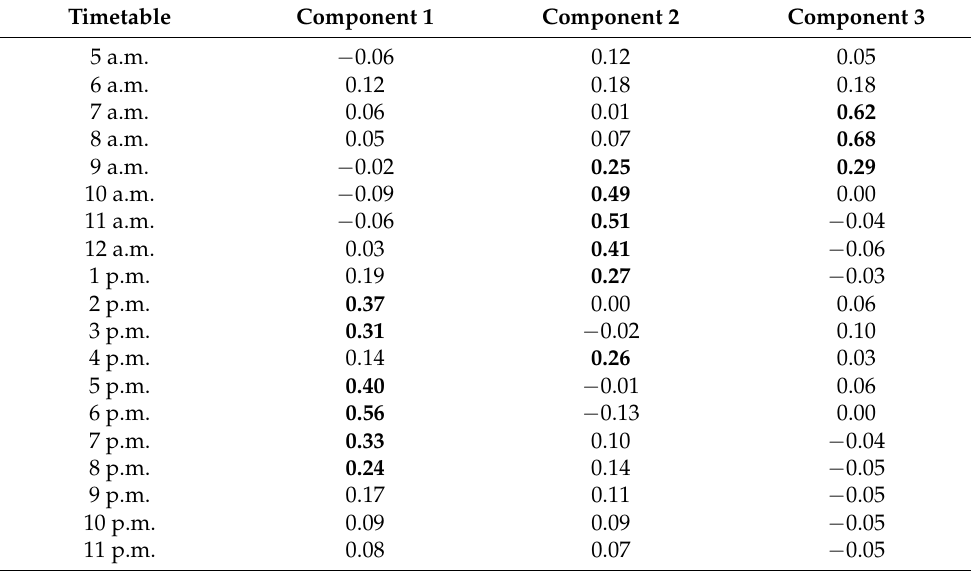
those with high loads in both components. Table 3. Component matrix B for timetable (with values exceeding 0.20 in absolute value indicated in